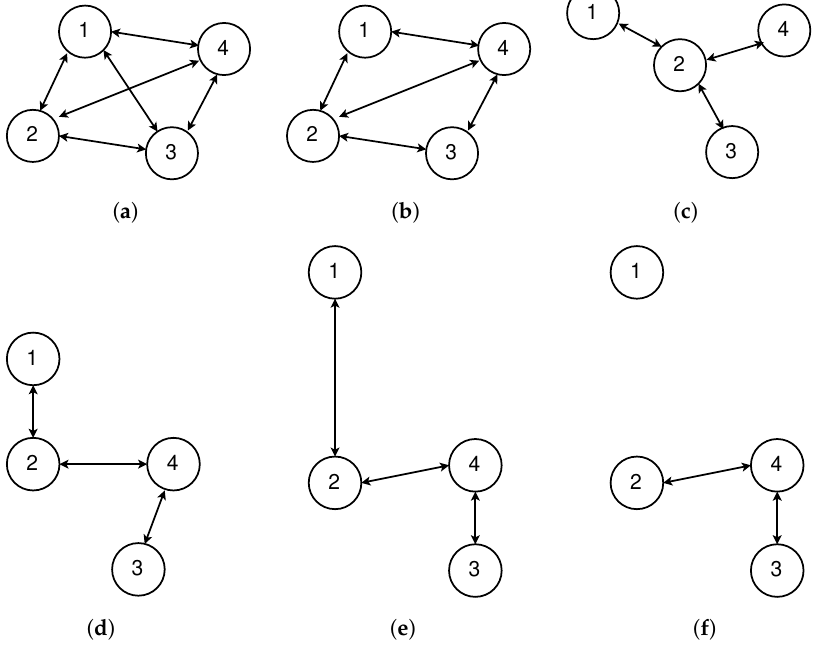
Figure 1. Topologies tested in the sea trial [6]: topology 1 ( a ), topology 2 ( b ), topology 3 ( c ), topology 4 ( d ), topology 5 ( e ), and topology 6 ( f